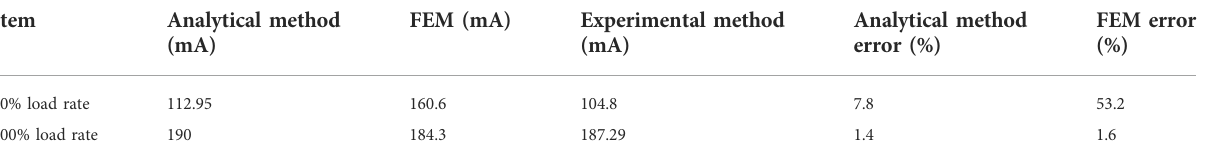
TABLE 4 Comparison of grounding current of the converter transformer core.